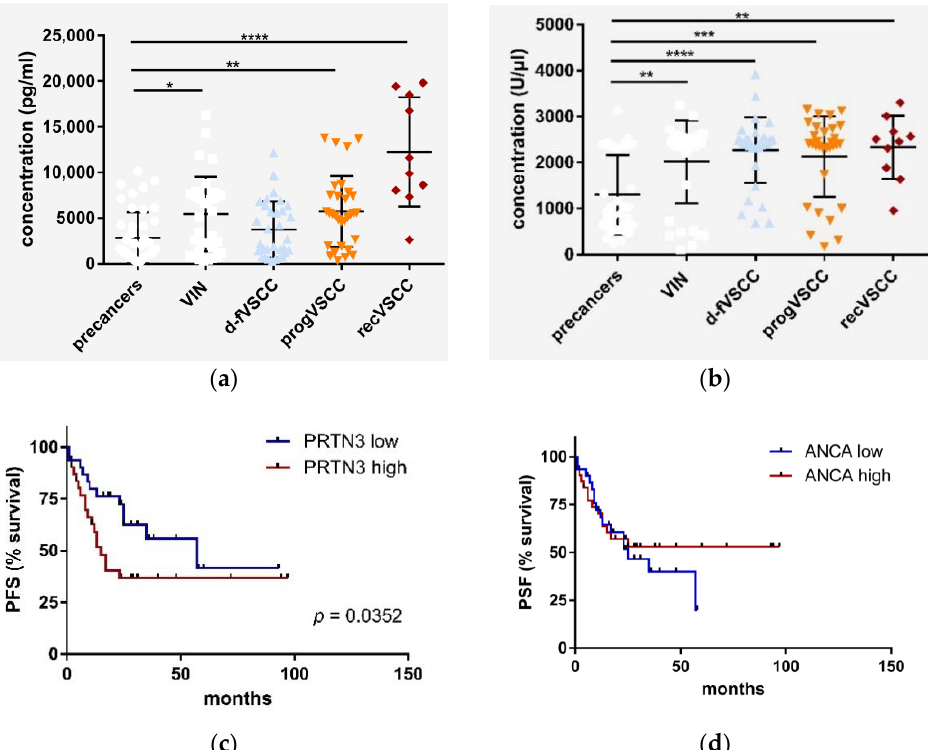
Figure 4. PRTN3 ( a ) and ANCA ( b ) serum levels. The results for the sera of 37 patients with vulvar pre-cancers (HSIL, n = 27; dVIN, n = 7), patients with primary ( n = 64) and recurrent VSCC ( n = 10) were compared to the control sera obtained from healthy women (( c ), n = 44). Survival curves (time to progression) according to the serum levels of ( c ) PRTN3 and ANCA in patients with primary VSCC (( d ), n = 64). Significant alternations are indicated by asterisks (*, p -value ≤ 0.05; **, p -value ≤ 0.01; ***, p -value ≤ 0.001; ****, p -value ≤ 0.0001). Abbreviations: PFS, progression-free survival; high, high protein level, i.e., above the cut-off value; low-protein level, i.e., below the cut-off value (i.e., the median of protein concentration).